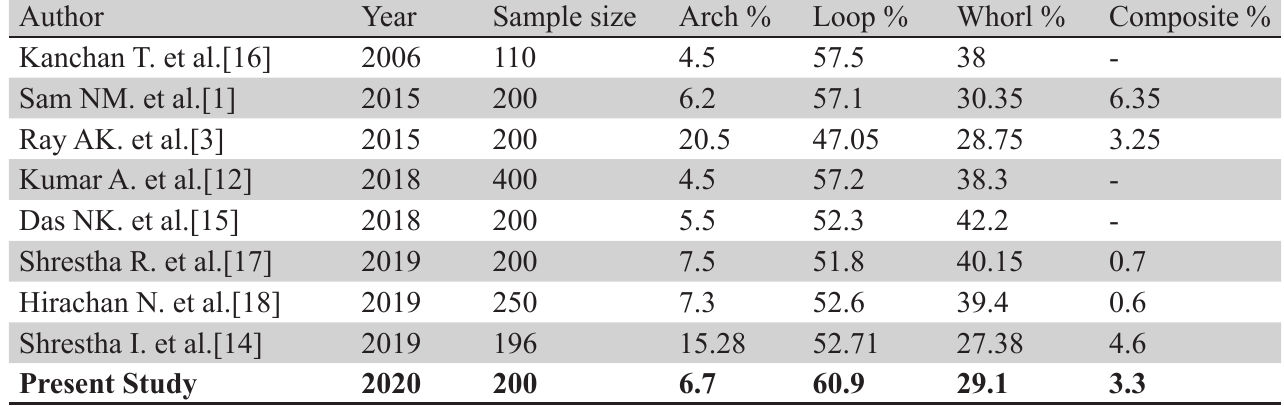
Table 2. Comparison of dermatoglyphics pattern among different